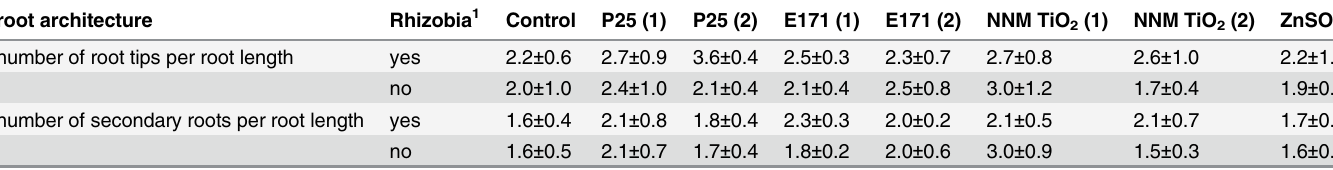
Table 3. Number of root tips and number of secondary roots of red clover in hydroponic system. Roots were assessed at the harvest (n = 6, mean ± standard deviation). Exposure concentrations (1 < 2) are described in detail in Table 2. root architecture number of root tips per root length number of secondary roots per root